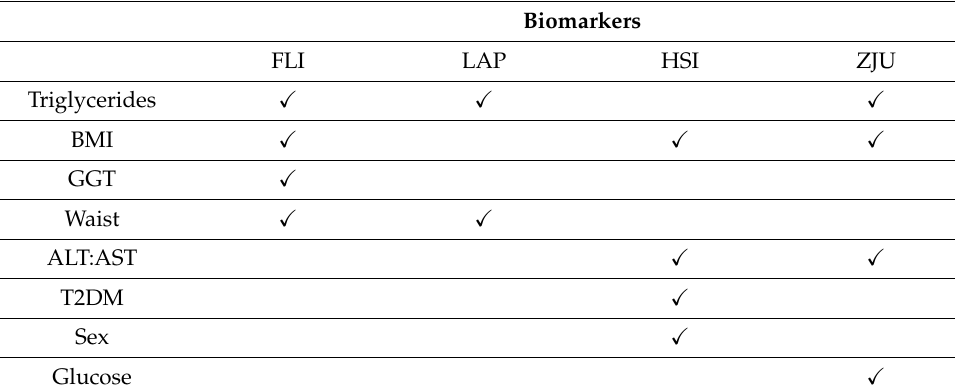
Table A2. Predictors employed by the biomarkers.